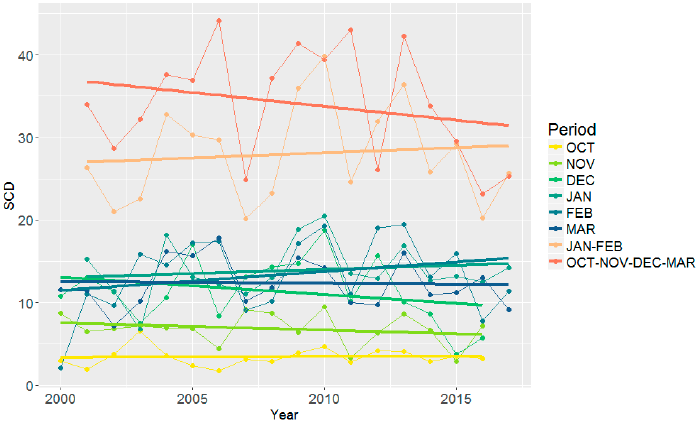
Figure 9 : Mean SCD of different months and periods averaged over all altitudinal ranges over the years 2000–2017.